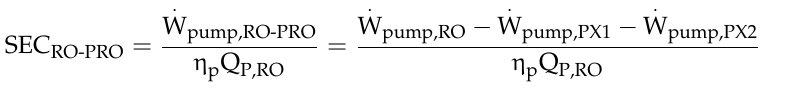
Figure 2. Schematic of RO with an energy recovery device (RO-ERD).